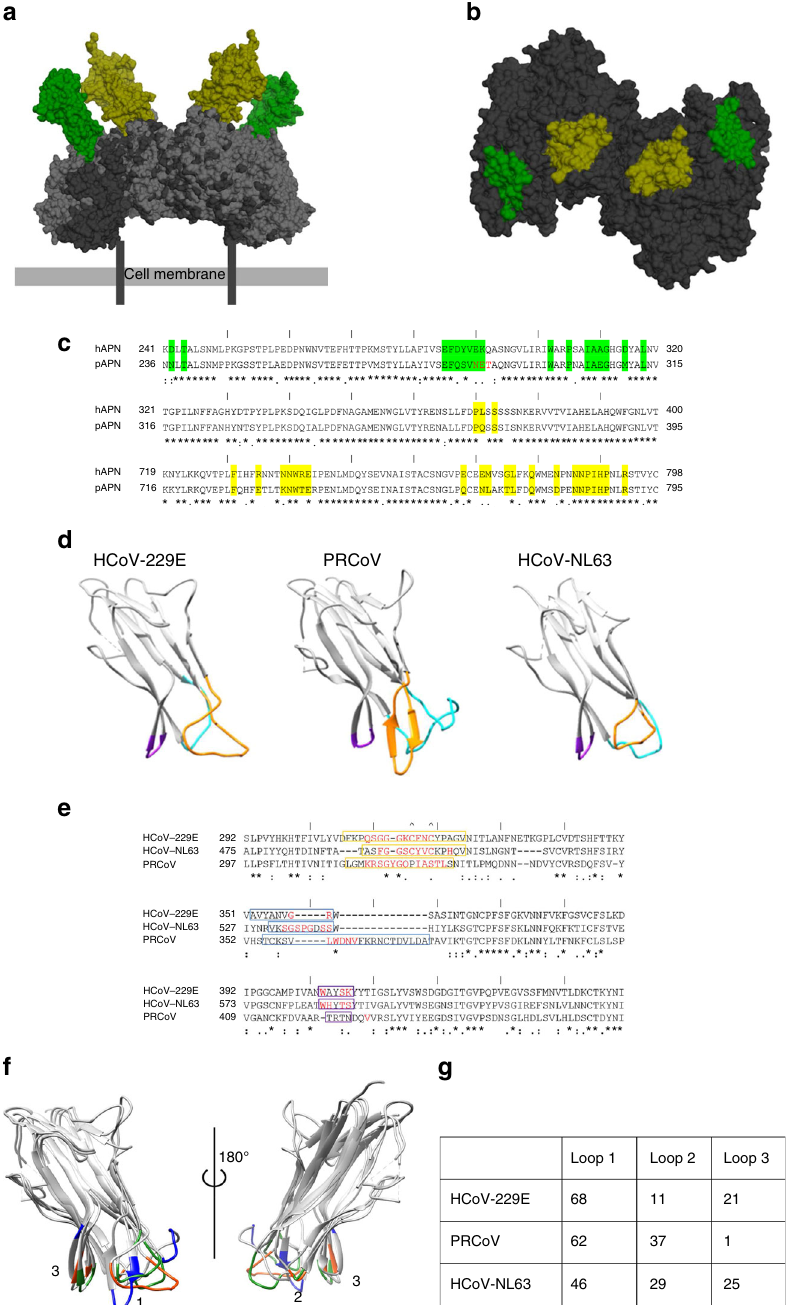
Fig. 3 Alphacoronavirus receptor-binding domains. a Surface representation of an APN-based overlay of the HCoV-229E RBD – hAPN and PRCoV RBD – pAPN complexes. Human APN (dark gray), porcine APN (light gray), HCoV-229E RBD (green), and PRCoV RBD (yellow). APNs are aligned on domain IV. b Top view of the APN surface buried by HCoV-229E RBD binding (H-site, green) and PRCoV RBD binding (P-site; yellow) mapped onto hAPN. c Sequence alignment of human and porcine APN. Residues in the H-site are highlighted in green and residues in the P-site are highlighted in yellow. The “ | “ symbol demarcates every 10 residues in the alignment. The N -glycosylation sequon (Asn residue 286) in porcine APN is shown in red (Glu residue 291 in human). d Ribbon representation of the HCoV-229E RBD (receptor: hAPN), the PRCoV RBD (receptor: pAPN), and the HCoV-NL63 RBD (receptor: hACE2). Loops 1, 2, and 3 are colored in orange, cyan, and purple, respectively. e Sequence alignment of the HCoV-229E, PRCoV, and HCoV-NL63 RBDs. Residues in loops 1, 2, and 3 are enclosed by orange, cyan, and purple boxes, respectively. The cysteine residues involved in the loop 1 disul fi de bond are indicated by “ ^ “ . The “ | “ symbol demarcates every 10 residues in the alignment. Residues directly interacting with the receptor are colored red. f Structural alignment of the HCoV-229E, HCoV-NL63, and PRCoV RBDs with receptor interacting residues colored orange, green, and blue, respectively. Numbers indicate the loop numbers. The structures are shown in two views rotated by 180 o relative to each other. g The percentage contribution made by each loop to the total surface area buried on the RBD in the receptor